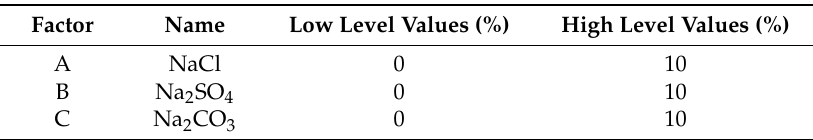
Table 3. The factors and levels of mixture experiments.